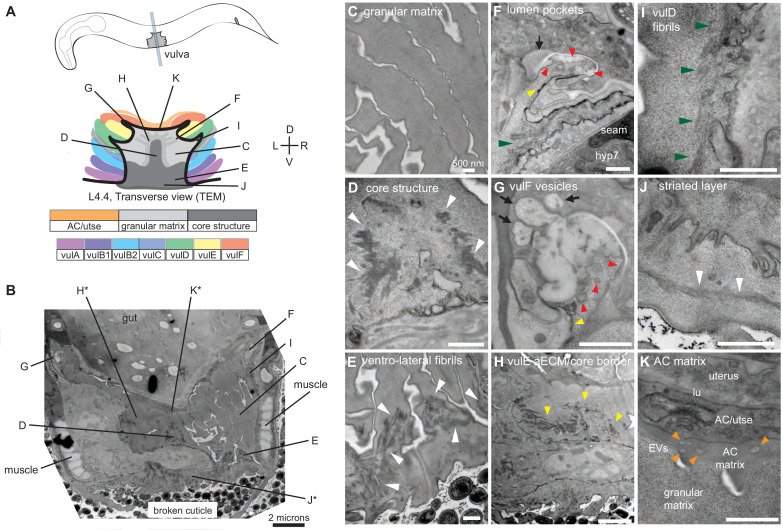
Ultrastructural features of the mid-L4 vulva aECM.Uncolored images from Figure 4 are shown.